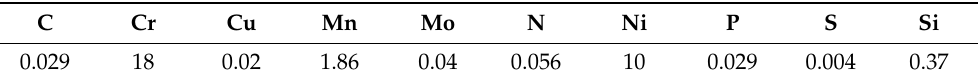
Figure 1. ( a ) Geometry of solid bar specimens (dimensions in mm); ( b ) schematic diagram of testing rig. Table 1. Chemical composition of 304 L stainless steel (wt.%, Fe balance).